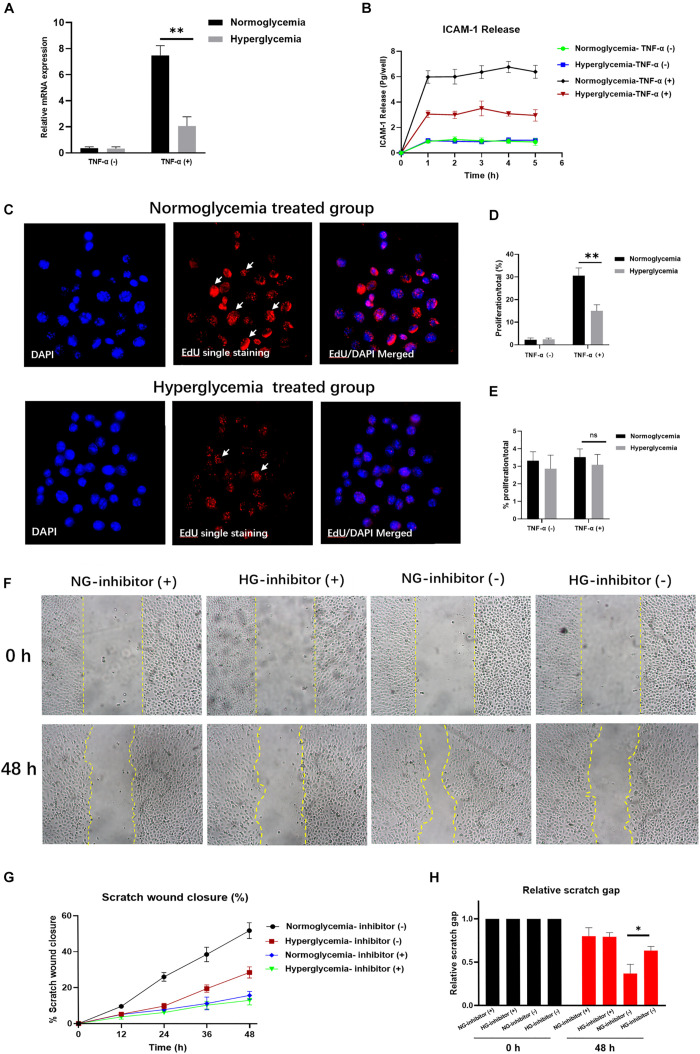
Hyperglycemia (HG) reduces ICAM-1 expression and attenuates endothelial cell (EC) proliferation. (A) ICAM-1 expression was lower in the HG group (P < 0.01). No significant differences were detected in their non-activated counterparts (NG; P > 0.05). (B) The total amount of ICAM-1 released into the basolateral chamber was decreased in the HG group. (C) EC proliferation was decreased in HG cultural medium. The contrast nuclear was stained with DAPI (blue) and presented in the left side. The cell proliferation was measured by 5-Ethynyl-2’-deoxyuridine (EdU) staining (red) and presented in the middle. White arrows indicate positive staining of EdU. The merged images were presented in the right. Images in upper side were from normoglycemia group. Images in lower side were from hyperglycemia group. (D) The expression of EdU was reduced in HG group, which indicated the low proliferation in HG culture medium. Little proliferation occurred in the absence of exogenous stimulation. (E) Proliferation rates declined markedly following exposure to an ICAM-1 inhibitor in the NG group. (F,G) In the HG group, the closure area was decreased at both 24 and 48 h post-scratching compared with the NG group. (H) The scratch gap distance tended to be wider in the HG group. The yellow line demarcates the closure area after scratching. Bars represent mean ± SD. *P < 0.05; **P < 0.01.